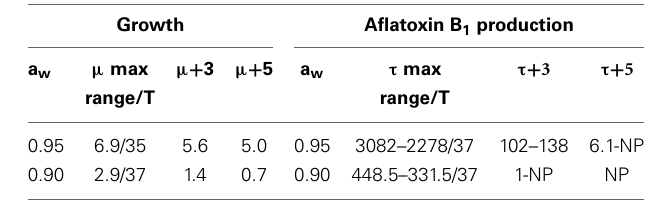
Table 1 | Changes in growth and toxin production by Aspergillus flavus due to increase in temperature by + 3 and + 5 ◦ C at different water stress conditions.